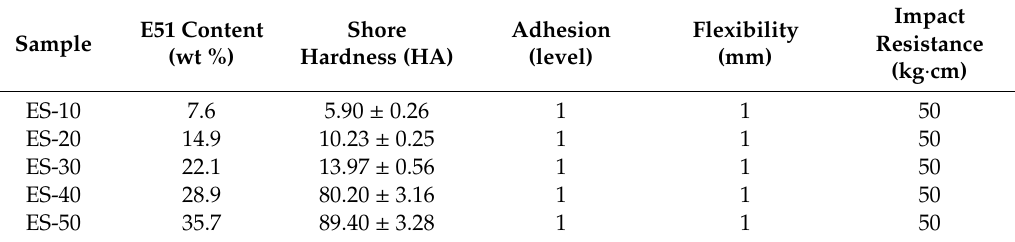
Table 3. Mechanical properties of epoxy modified silicone coatings.